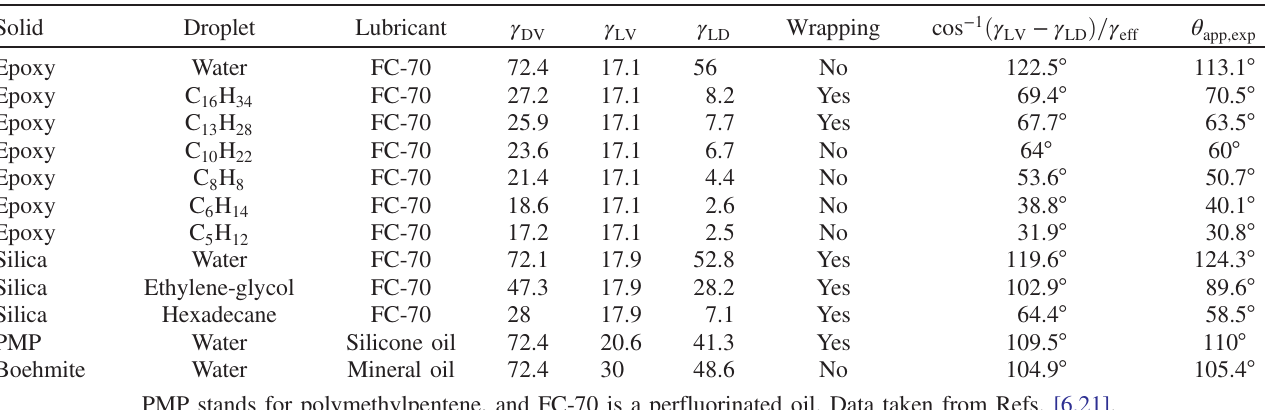
TABLE III. Contact angle